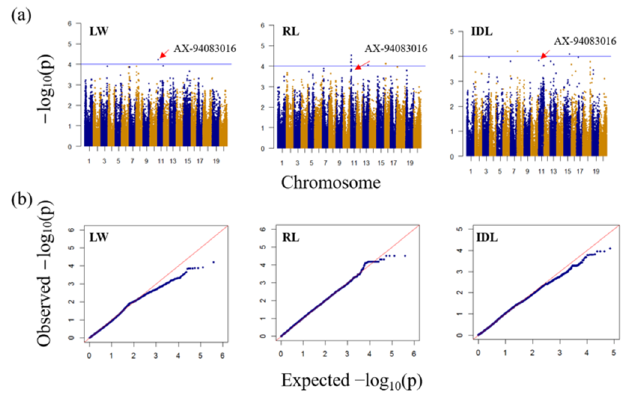
Figure 4. Genome-wide association analysis (GWAS) of the larval weight (LW), resistance level (RL) and index of damaged leaf (IDL) with the mean values of two years. ( a ) Manhattan plots describe the GWAS results using 110,117 SNPs. Horizontal lines represent an interesting threshold (−log 10 p = 4.00), and AX-94083016 is indicated. ( b ) Quantile–quantile (qq) plots for three traits.